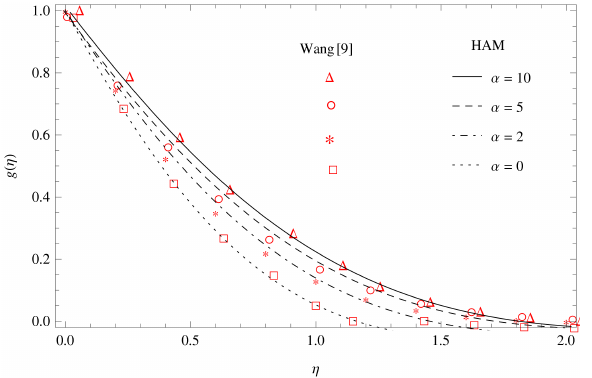
Fig. 28: Comparison of velocity profile g for Wang [9] and HAM solu- tion